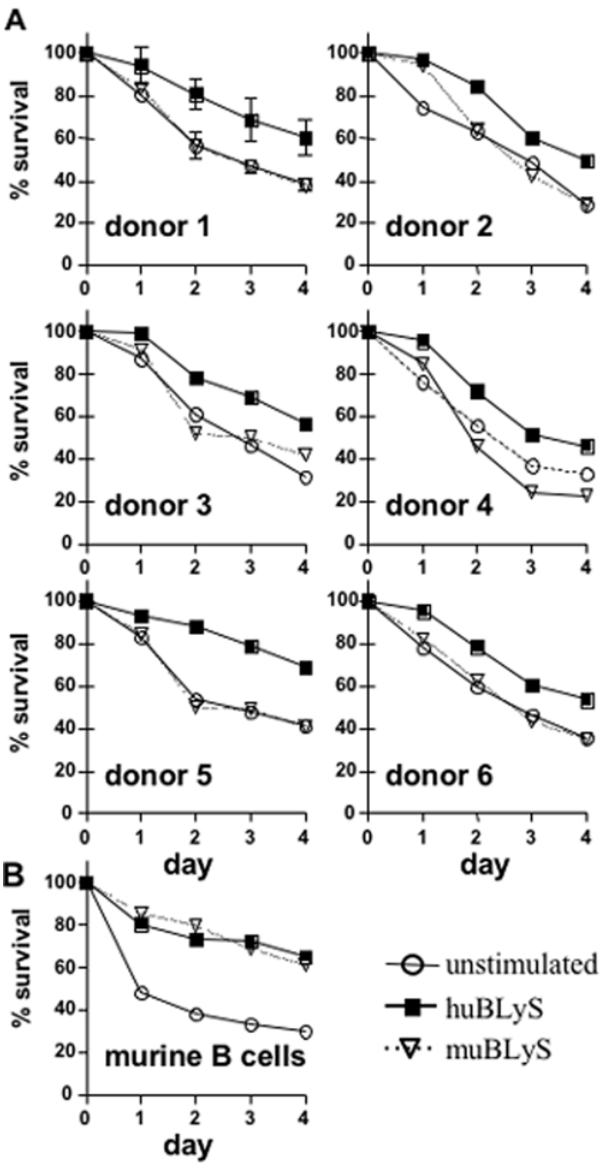
Figure 1. In vitro survival of CD19 + human B cells with human or murine BLyS. CD19 + B cells were purified from PBL by negative selection using RosetteSep kit and ficoll hypaque centrifugation. B cells were cultured for 4 days with 100 ng/ml of human or murine BLyS, cultures were resupplemented with BLyS on day 2. Viability was determined daily using cell counting with trypan blue and is represented as percentage of input cell number surviving. Donor 1 data is the average of 2 separate B cell preparations; donors 2–6 represent a single cell preparation. Statistical analysis for significance after 4 days in culture; huBLyS vs. muBLyS, p=0.0041; huBLyS vs unstimulated, p=0.0014; muBLyS vs. unstimulate, p=ns.